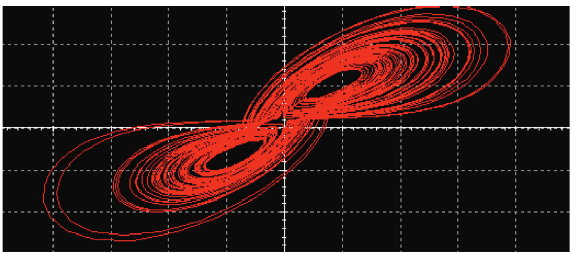
Figure 18: ( x, y ) space portrait of the Multisim simulation of equations (54)–(56).